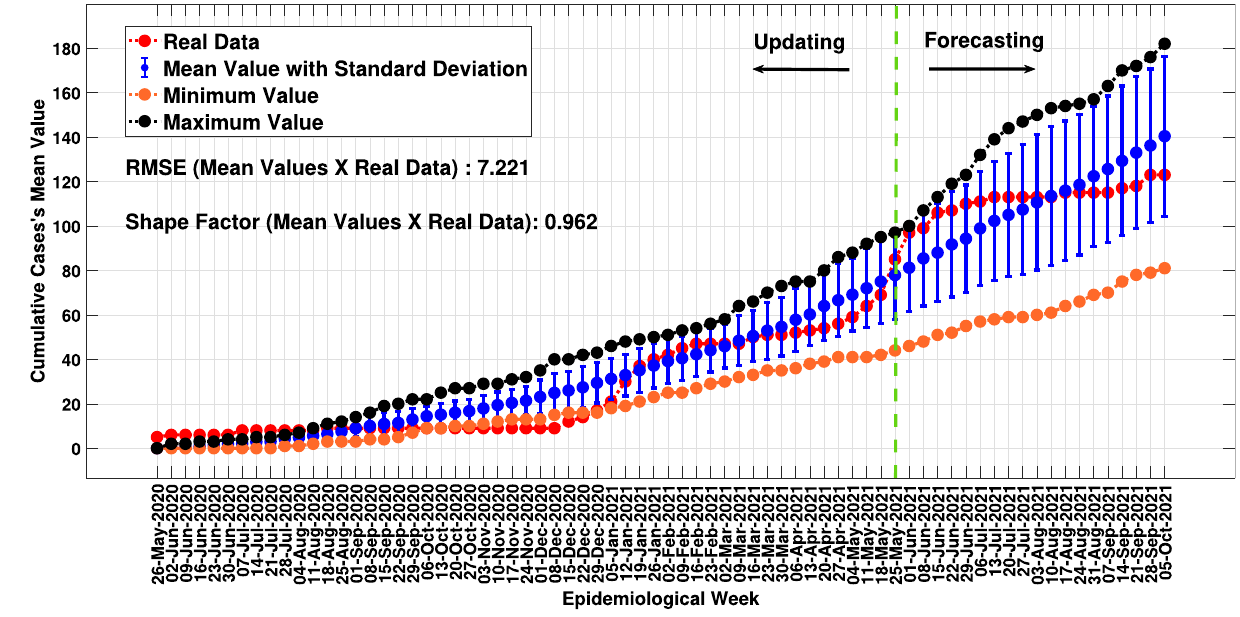
Figure 13. Cumulative infected curve defined by mean values and their comparison with the real data